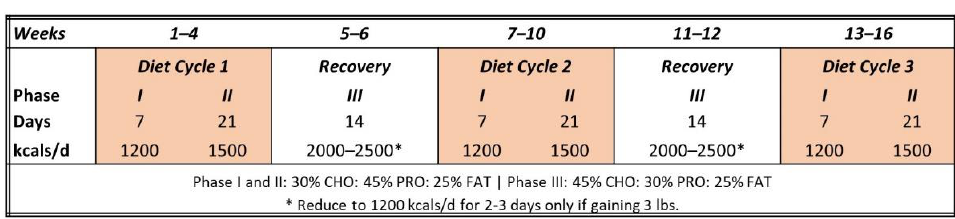
Figure 3. Overview of the CV diet intervention.